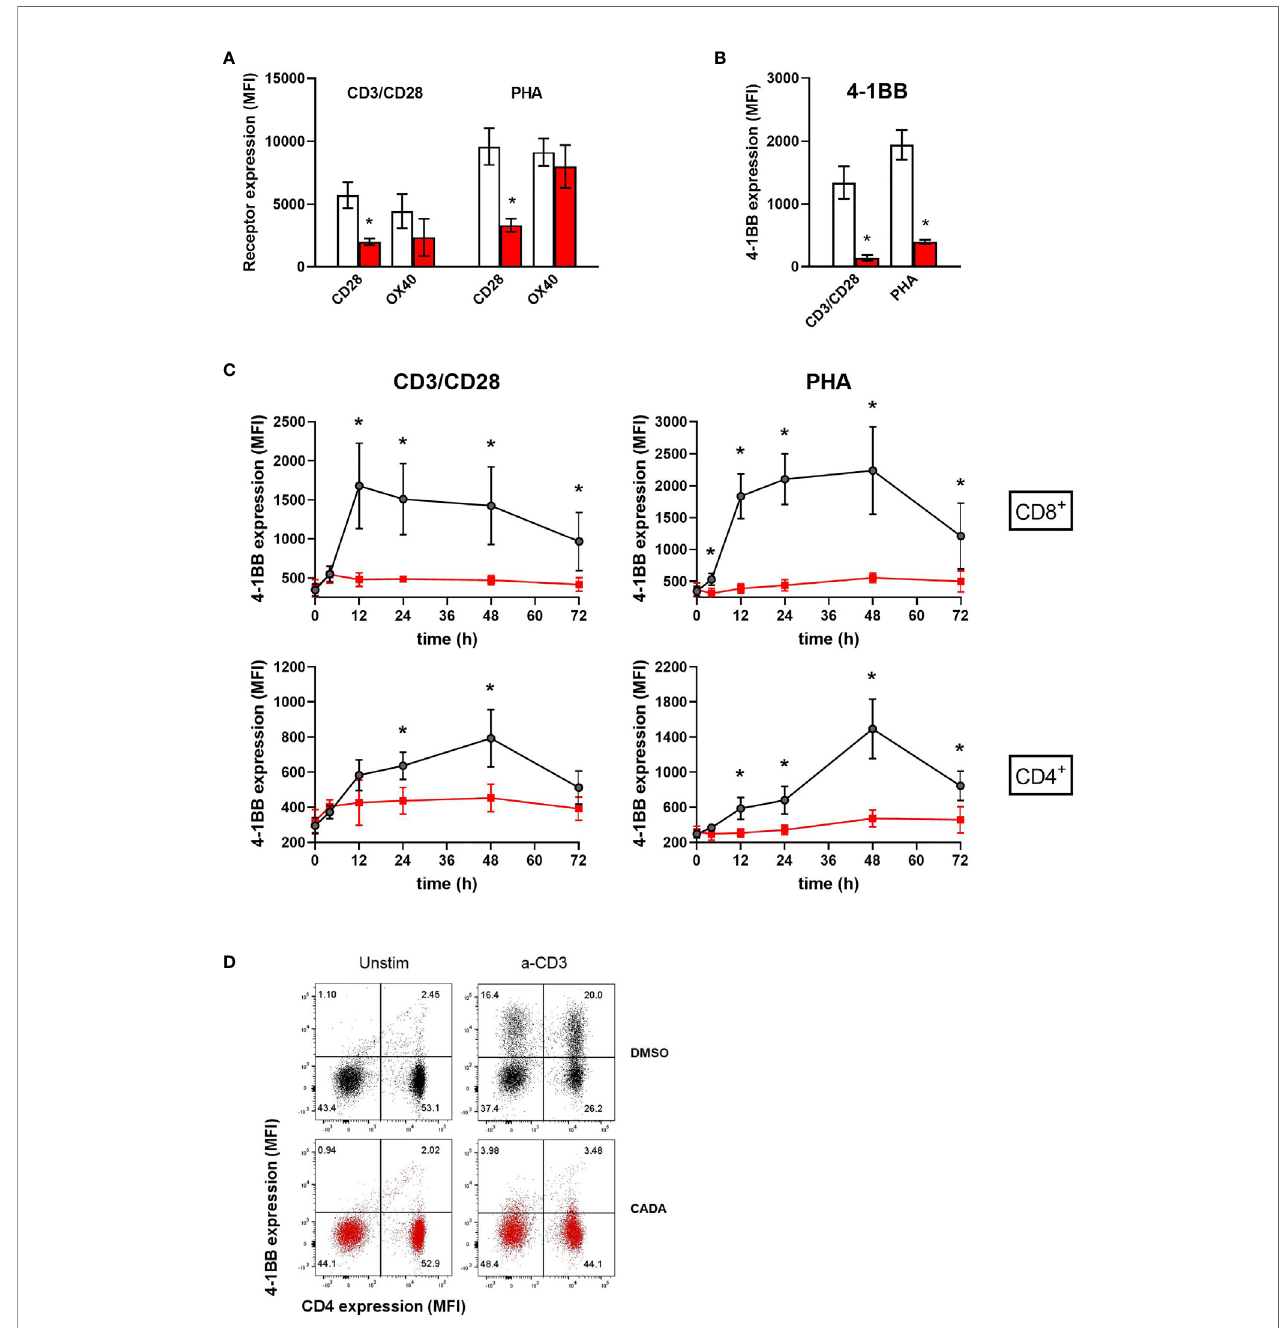
FIGURE 6 | CADA strongly suppresses the upregulation of the co-stimulatory molecule 4-1BB in activated PBMCs. (A, B) PBMCs were pre-incubated with CADA (10 m M) or DMSO for 3 days, after which they were activated by CD3/CD28 beads or PHA. Cell surface CD28 expression was measured on gated CD4 + T cells by fl ow cytometry on d3 post activation. Cell surface expression of OX40 and 4 ‑ 1BB was measured on total PBMCs by fl ow cytometry on d2 post activation. Bar diagrams are showing the MFI for the indicated receptor, with DMSO in white and CADA in red. Paired t-tests were performed to compare CADA to DMSO with *p<0.05. Values represent mean ± SD of four different donors (n=4). (C) PBMCs were pre-incubated with CADA (10 m M) or DMSO for 3 days, after which they were activated by CD3/CD28 beads or PHA. Cell surface 4 ‑ 1BB expression was measured on gated CD4 + and CD8 + T cells by fl ow cytometry on the indicated time points post activation. Multiple t-tests were performed to compare CADA to DMSO for each condition with *p<0.05 and with Holm-Sidak method as correction for multiple comparison. Curves are showing mean values ± SD of six different donors (n=6). (D) PBMCs were pre-incubated with CADA (10 m M) or DMSO for 2 hours, and subsequently activated by anti-CD3 antibodies only. Cell surface CD4 and 4 ‑ 1BB expression was measured by fl ow cytometry at 24h post activation. Representative dot plots for CD4 and 4 ‑ 1 BB double staining are shown for unstimulated and stimulated cells. Do note that this short CADA-treatment has neglectible effect on the CD4 expression in unstimulated cells (see lower right quadrants), but blocks the expression of 4 ‑ 1BB in activated cells, both in CD4 negative (upper left quadrant) and CD4 positive cells (upper right quadrant). See also Supplementary Figure 6